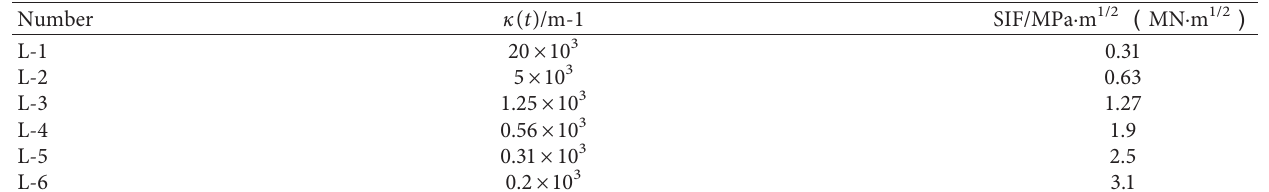
Table 2: Crack tip curvature and stress intensity factor (SIF) parameters.